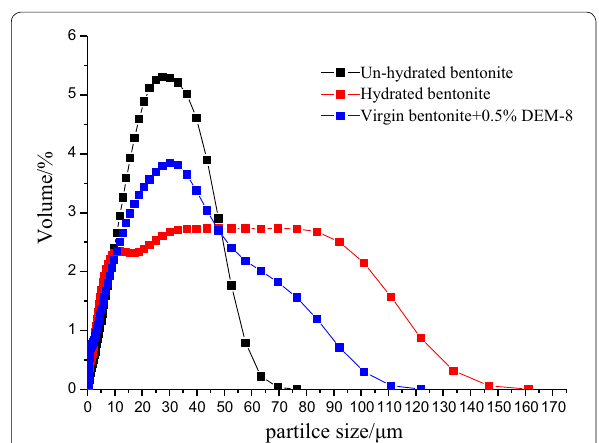
Fig. 4 The distribution of clay particle size in different suspensions